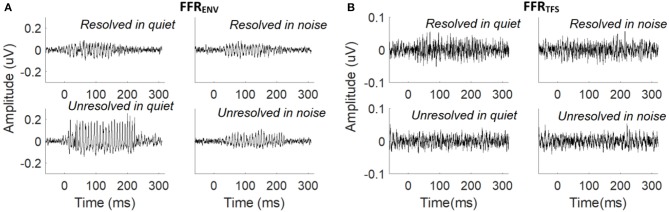
(A) Grand average FFRENV waveforms to the resolved stimuli in quiet and noise (top panel) and unresolved stimuli in quiet and noise (bottom panel). (B) Grand average FFRTFS waveforms to the resolved stimuli in quiet and noise (top panel) and unresolved stimuli in quiet and noise (bottom panel).